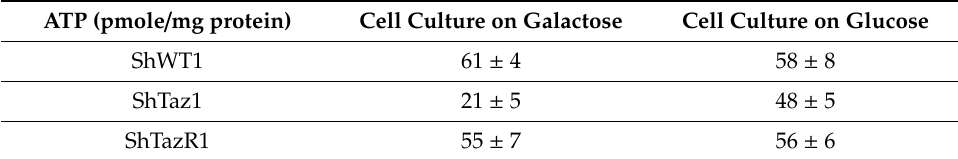
Table 3. Measurement of the cellular ATP content in di ff erent culture conditions. Glycolysis is favored by cell culture in galactose, whereas both mitochondria and glycolysis are at work when the culture is on glucose. ATP (pmole / mg protein) Cell Culture on Galactose Cell Culture on Glucose ShWT1 61 ± 4 58 ± 8 ShTaz1 21 ± 5 48 ± 5 ShTazR1 55 ± 7 56 ±